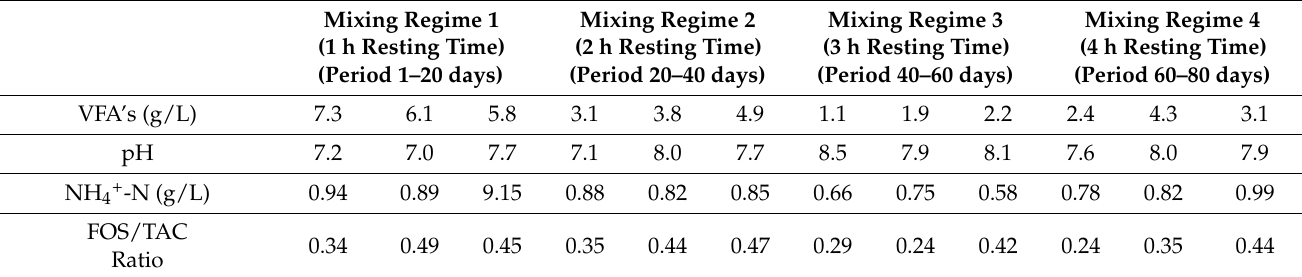
Table 5. Average performance values of the digesters at various mixing-resting intervals.